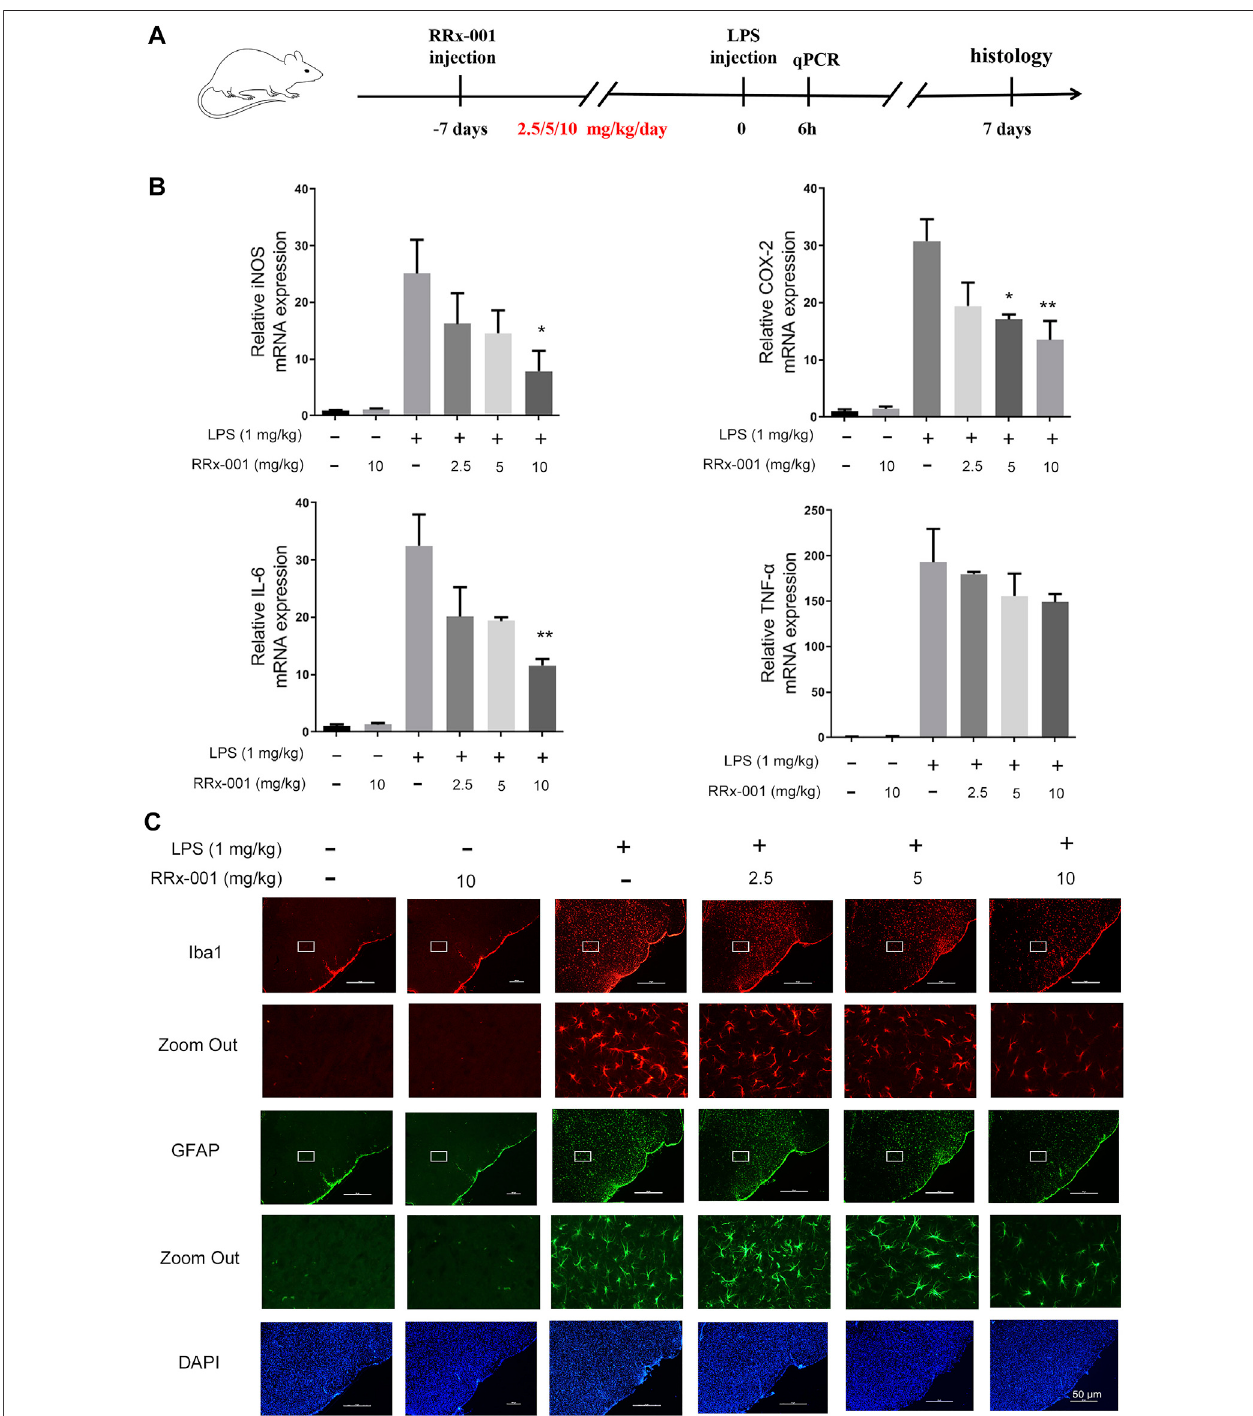
FIGURE 10 | RRx-001 suppressed LPS-induced neuroin fl ammation and dopaminergic (DA) neuronal loss in the midbrain. (A) The scheme for in vivo experiments in animals. RRx-001 with different doses (2.5, 5, 10 mg/kg) was injected intraperitoneally once a day for 7 days before stereotactic injection of LPS. Six hours after modeling,thetotalRNAwasextractedfromthemidbrainforreal-timequantitativePCRassay.SevendaysafterLPSinjection, themiceweresacri fi ced,and20 µM-thick slices of the midbrain were sectioned by using a freezing microtome for immunohistochemical assay. (B) After the total RNA was extracted, the mRNA levels of iNOS, COX-2, TNF- α , and IL-6 were determined with qRT-PCR. (C,D) Microglia and astrocytes were shown by immunohistochemical staining with anti-Iba1 and anti- GFAP antibodies, respectively. And the nuclei were stained with DAPI. The microglia and astrocytes were then imaged with fl uorescence microscopy, and